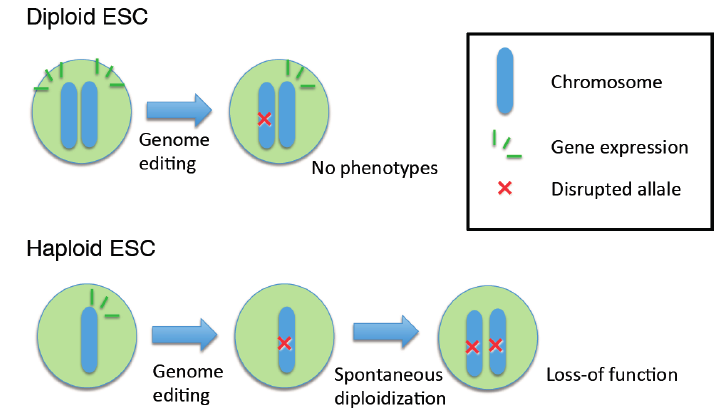
Figure 1. Haploid embryonic stem cells (ESCs) are useful for studying gene functions because disruption of a single allele can cause loss-of-function